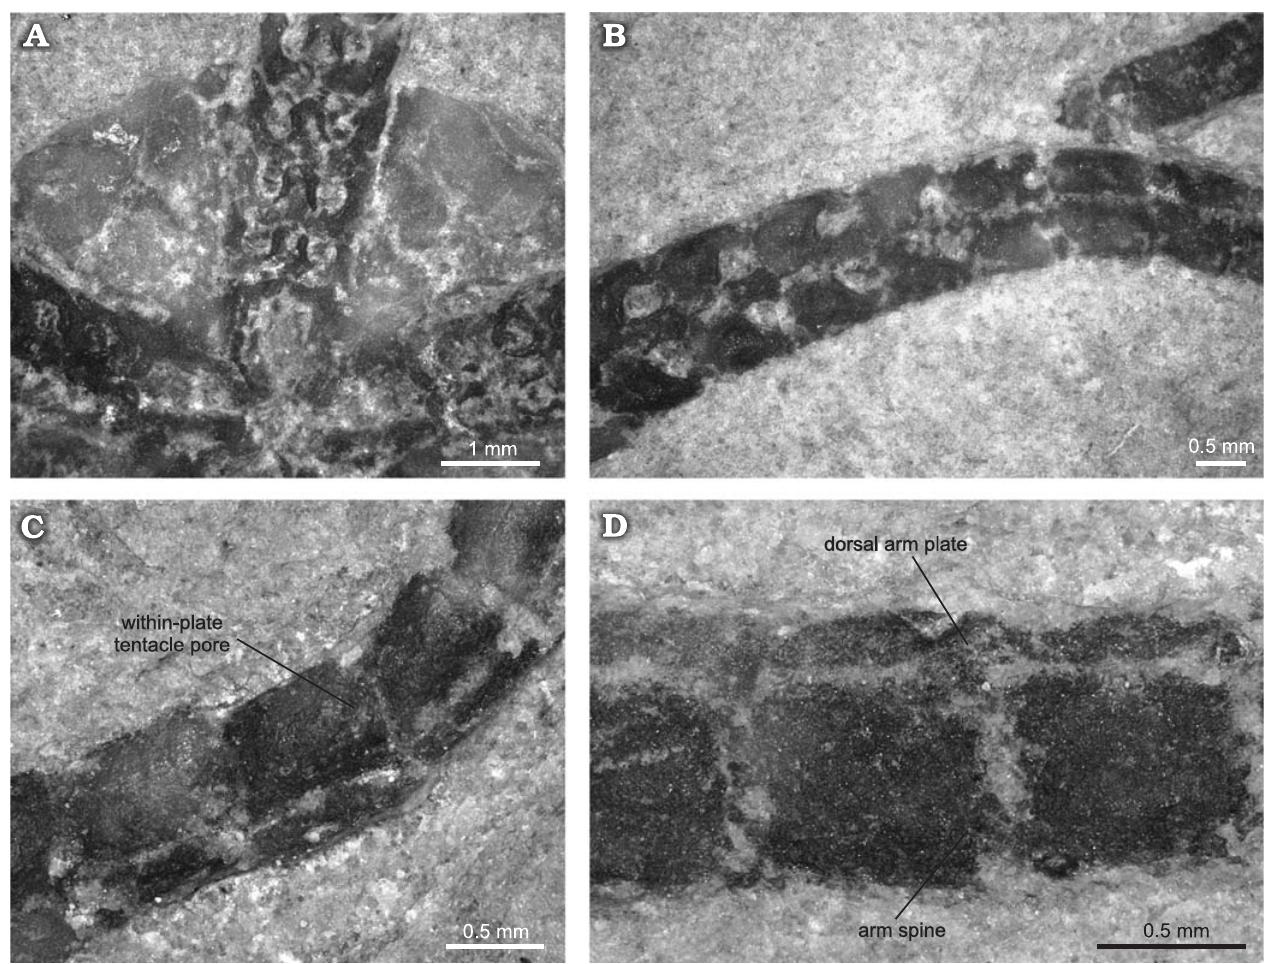
Fig. 3. Ophiurin brittle star Aganaster jagiellonicus sp. nov. from the upper Tournaisian to lower Visean (lower Carboniferous) Mazurowe Do ł y Formation, Rudawa Group of Czatkowice quarry, D ę bnik Massif, southern Poland; MZUJ T/0282, holotype. Detail of ventral side ( A ); median arm segments, show- ing the transition from between-plate tentacle pores to within-plate tentacle pores ( B ); median arm segments in ventro-lateral view ( C ); proximal arm segments in dorso -lateral view ( D